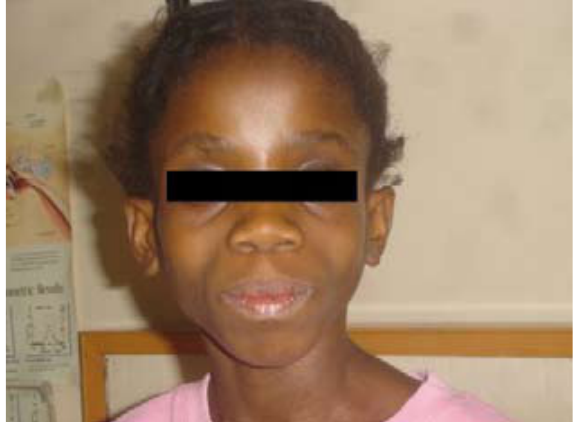
Fig. 5. Severe LA of the face, front view. This patient’s LA was already advanced when she was changed from a stavudine- containing regimen 4 years previously. Her LA is unlikely to